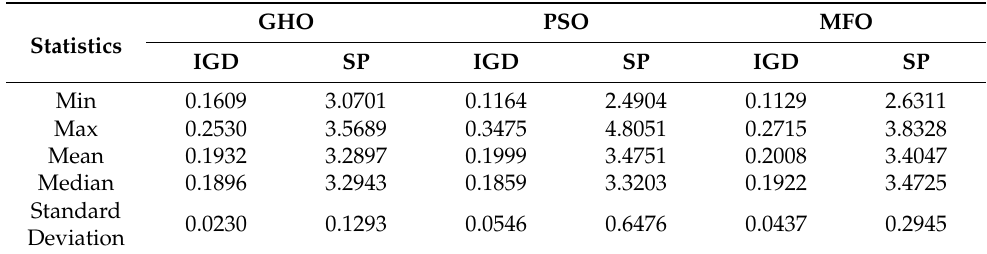
Table 11. Statistical performance of